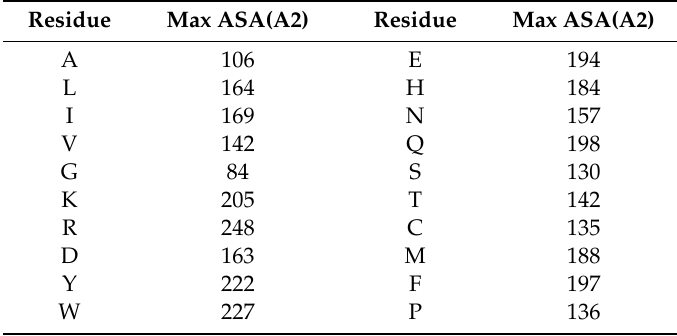
Table 7. Max accessible surface area (ASA) of 20 amino acids.